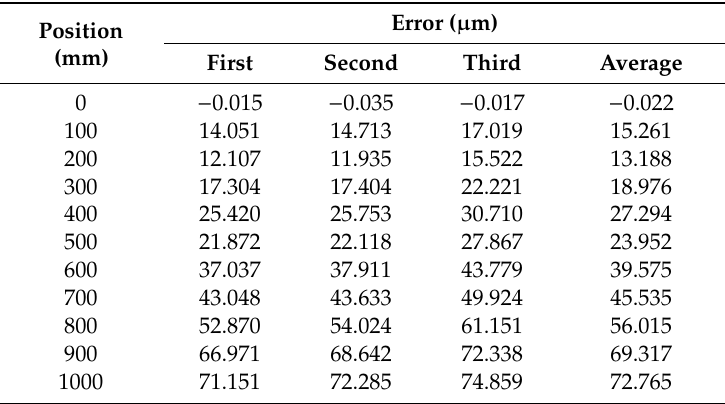
Table 8. Position error in the Y